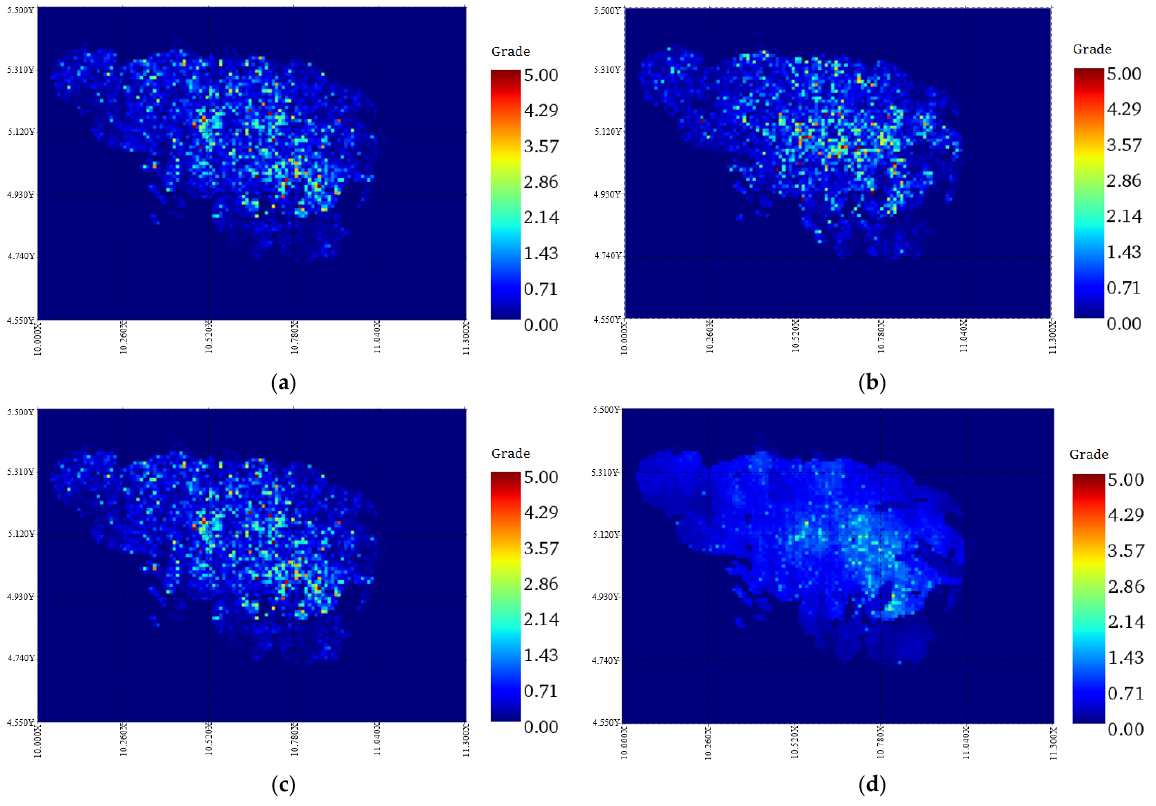
Figure 4. z = 2015 m-plan-views of copper grades for BMT, simulated realizations ( a – c ) and E-Type model ( d ).